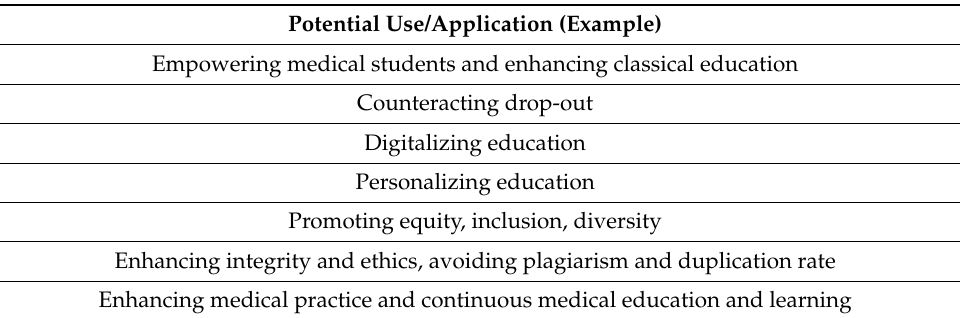
Table 2. Uses and applications of big data in the field of biomedical